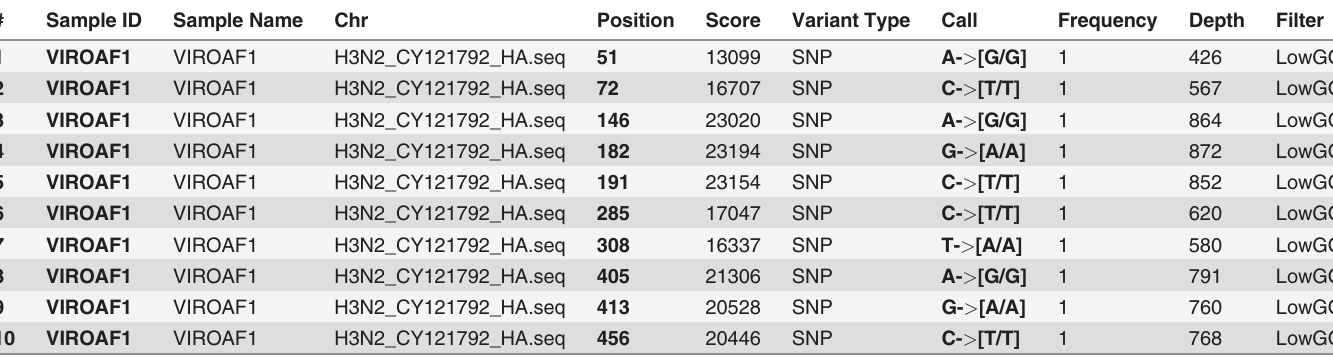
Table 1. Detected SNPs in HA gene fragment from sample #VIROAF1 ( “ AF1_HA.csv ” ).